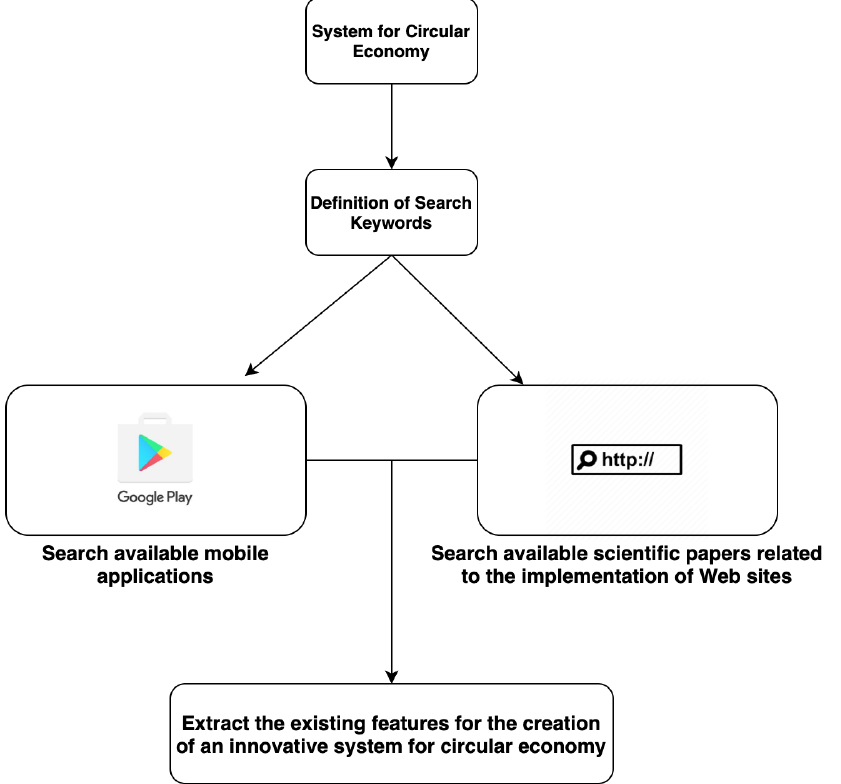
Figure 2. Proposed